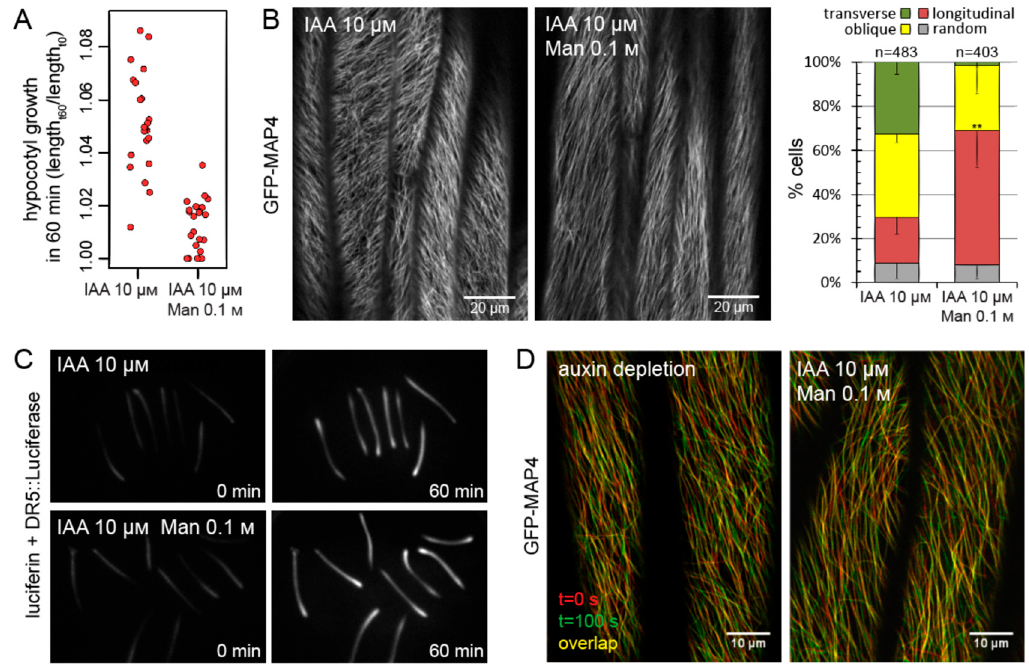
Figure 5. Cortical microtubule array reorientation triggered by auxin depends on growth. ( A ) Reduction in rates of auxin-induced growth of hypocotyl segments by increased osmolarity. 0.1 M of mannitol (Man) was added to the medium to counteract water uptake and turgor increase. The graph shows collated growth measurements from three experiments, each data point representing one hypocotyl. ( B ) Auxin-induced reorientation of microtubules into transverse arrays depends on growth. In auxin-treated hypocotyls which are prevented from growing rapidly by 0.1 M of mannitol, microtubules do not reorient towards transverse arrays e ffi ciently after a one hour growth period. The GFP fluorescence is depicted in grayscale. The graph shows average percentage of cells in each category from four experiments. Error bars indicate standard deviation (only the lower bar is shown for clarity). Total cell numbers are given above the graph. The frequencies of cells with longitudinal arrays were compared using a t test, p = 0.0045 (**). ( C ) Control for auxin signaling. 0.1 M of mannitol did not interfere with auxin signaling in hypocotyl segments, as visualized using luciferin and the DR5:Luciferase auxin signaling reporter line. ( D ) Control for microtubule dynamics. In hypocotyls treated with 0.1 M of mannitol, microtubules exhibited normal signs of assembly and disassembly. Longitudinal arrays after combined IAA and mannitol treatment are compared with similar longitudinal arrays in auxin depleted hypocotyls. Two pictures taken 100 s apart are overlapped. The overlapping fraction of microtubules is shown in yellow, while red and green shows microtubules that di ff er, demonstrating the occurring polymerizations and depolymerizations. The figure is representative for 39 movies captured per treatment